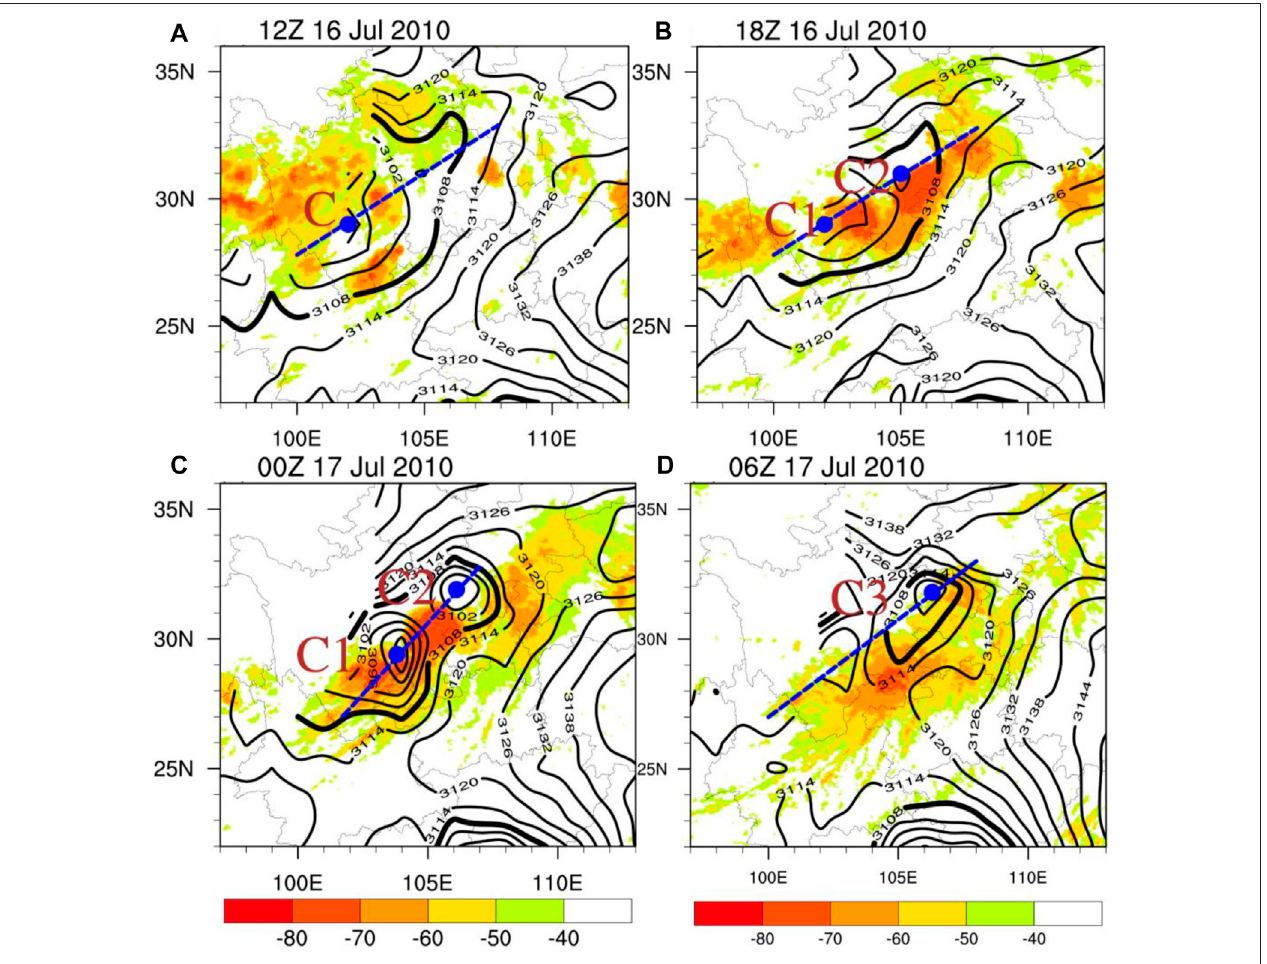
FIGURE 4 | Spatial distributions of the 700 hPa geopotential height (gpm, contours) and Japan MTSAT-2 infrared temperature ( ° C, shaded) at (A) 12:00 UTC July 16, (B) 18:00 UTC July 16, (C) 00:00 UTC July 17, and (D) 06:00 UTC July 17. The blue lines are used to intercept the cross sections in Figures 5 , 6 .